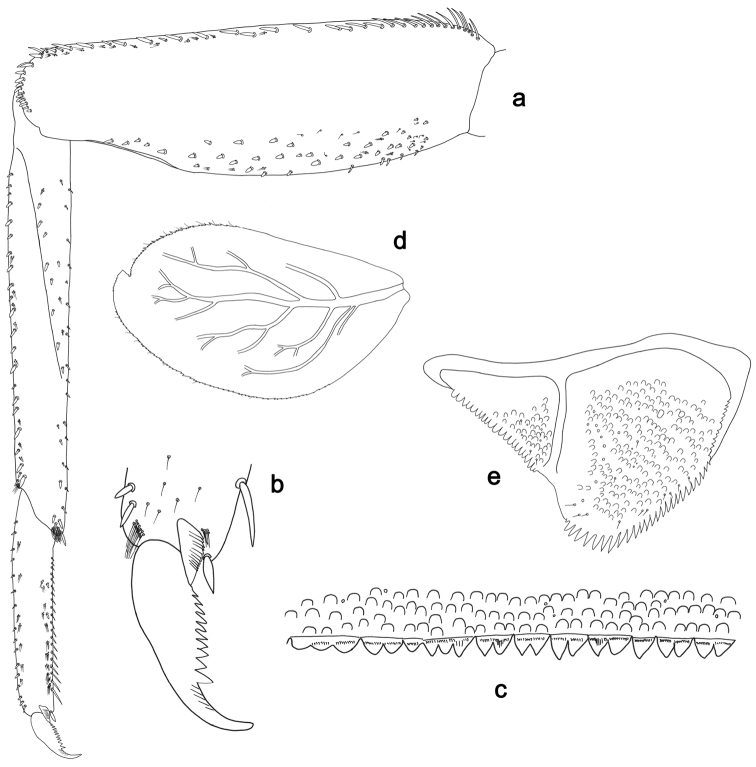
Labiobaetisparavultuosus sp. n., larva morphology: aForelegb Fore claw cTergum IV d Gill IV eParaproct.